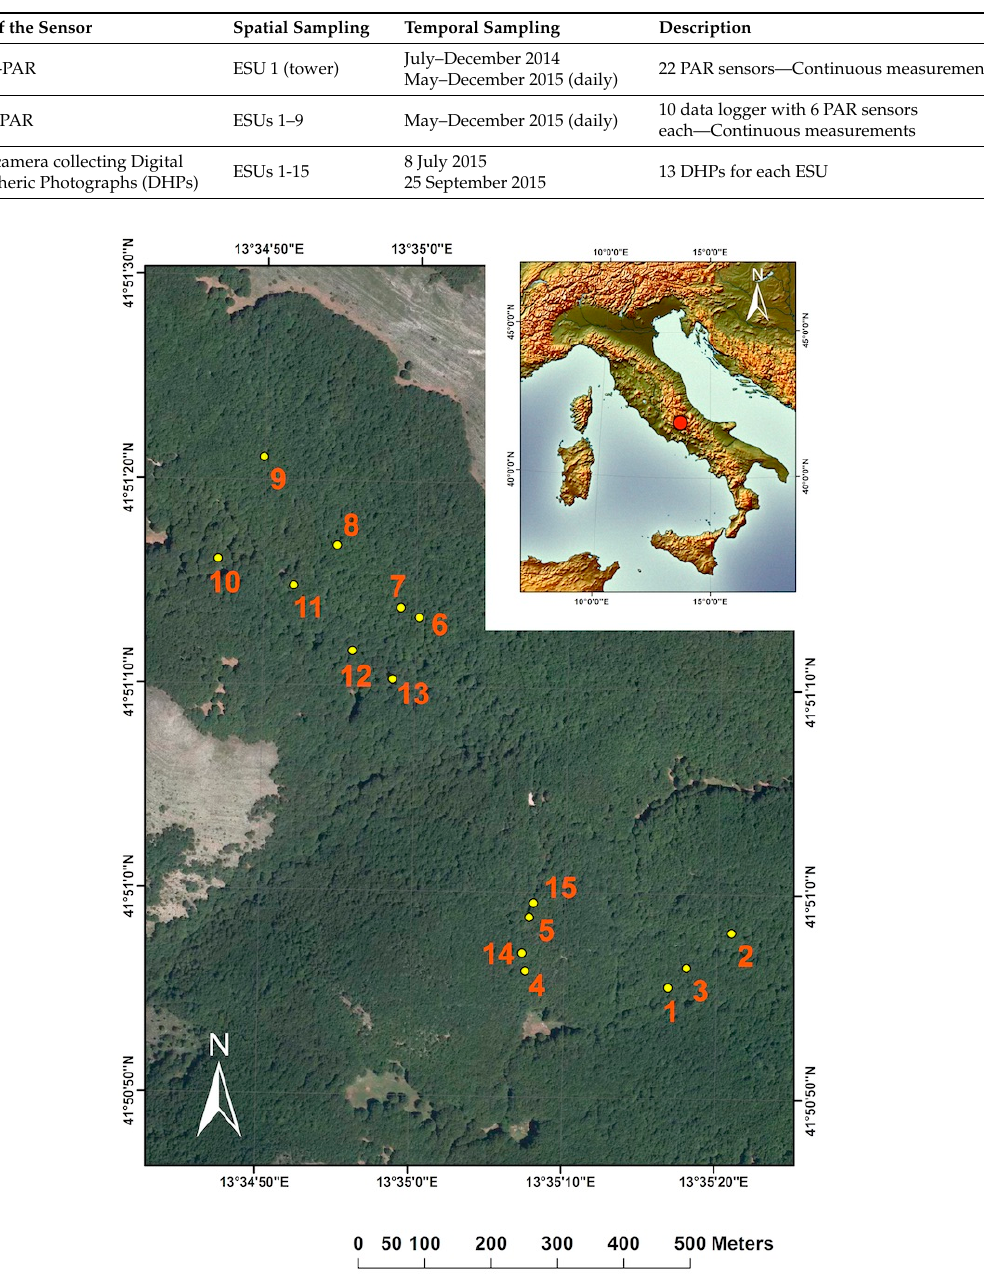
Figure 1. Spatial sampling design of the ground measurements over a 1 km × 1 km area at Collelongo. ESU 1 was centered at the flux tower and equipped with Apogee sensors. ESUs 1–9 were equipped with PASTIS sensors. All 15 ESUs were involved in the Digital Hemispheric Photographs campaigns. Further details can be found in the text. Image credits: Geocatalogo Regione Abruzzo (WMS service, orthophoto from 2013); inset image: NaturalEarthData (http://www.naturalearthdata.com).